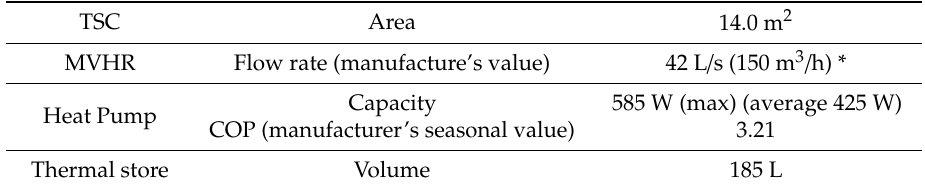
Table 3. Specification of thermal system (design values).